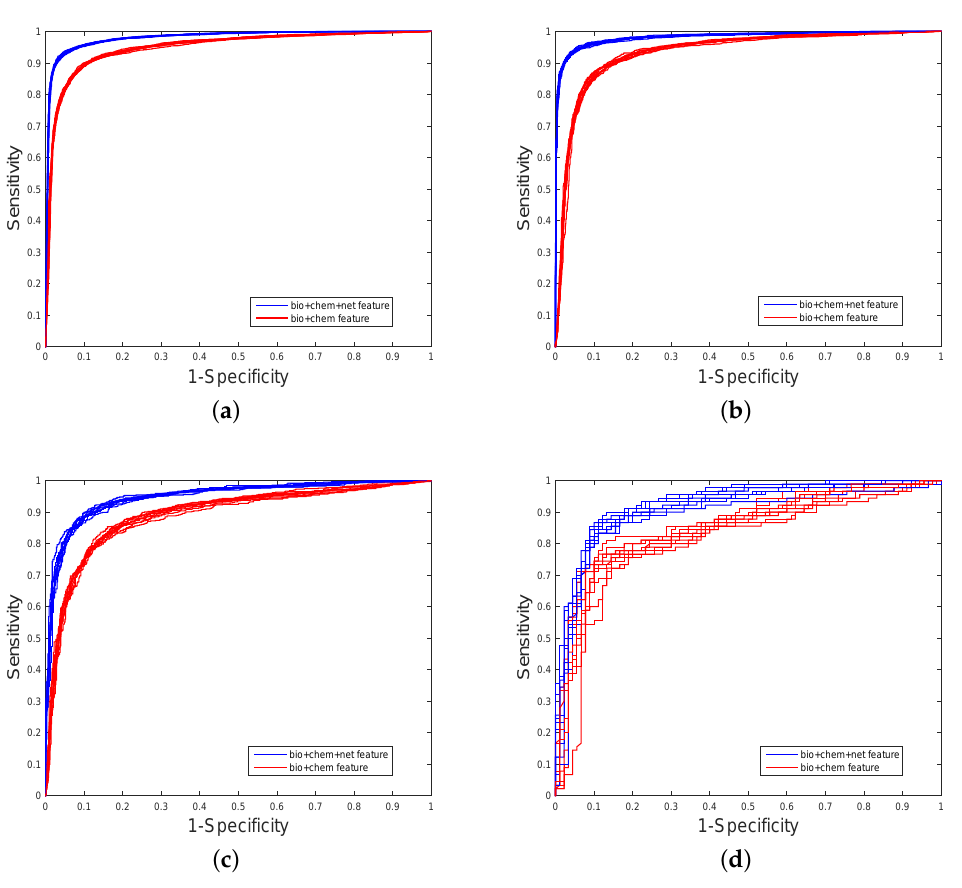
Figure 1. The area under the Receiver Operating characteristic Curve (ROC) values obtained on balanced datasets (with FS). The blue curve is the combined feature of MACCS (chem), DWT (bio), and net. The red curve is the combined feature of MACCS (chem) and DWT (bio); ( a ) Enzyme’s ROC curve with network feature; ( b ) IC ’s ROC curve with network feature; ( c ) GPCR’s ROC curve with network feature; ( d ) Nuclear receptor’s ROC curve with network feature.